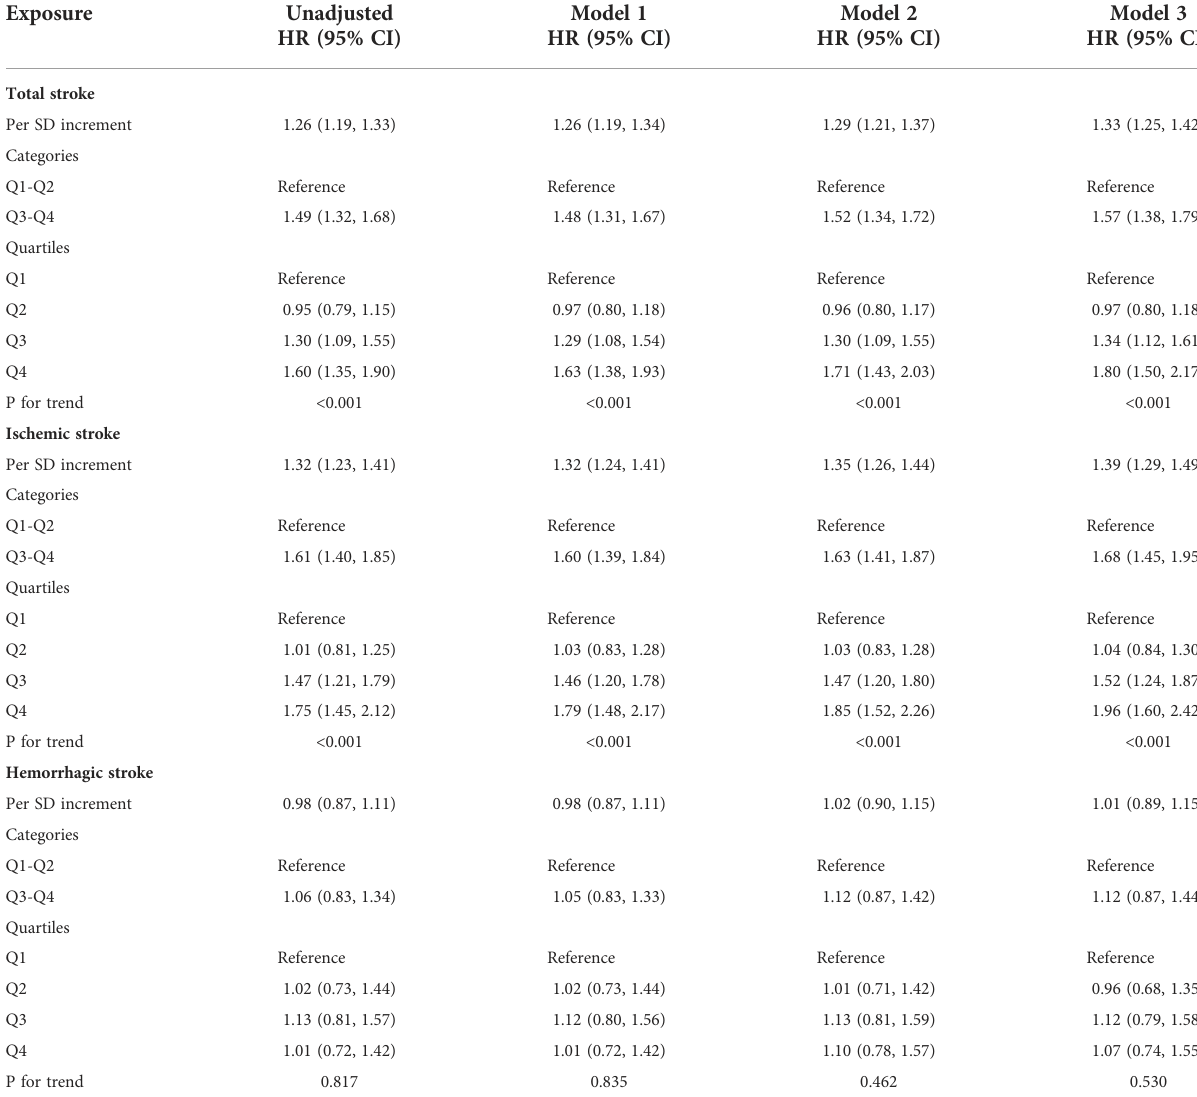
TABLE 2 Associations between METS-IR and clinical